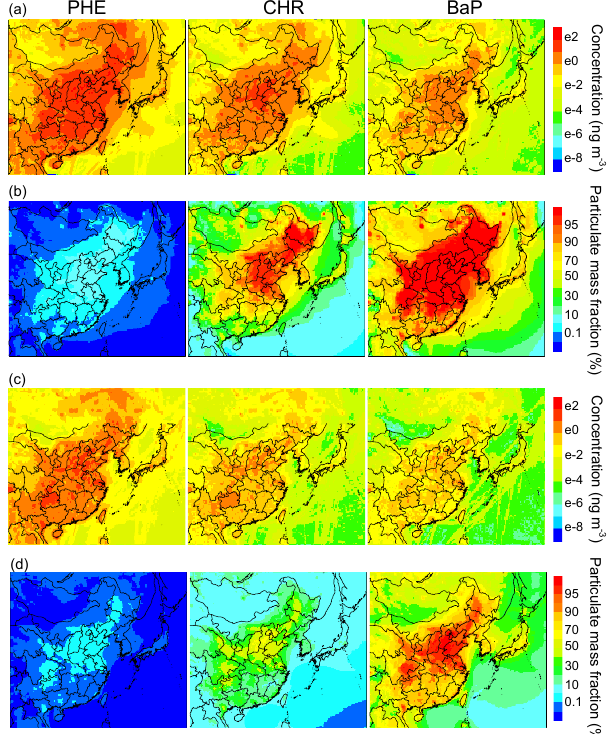
Figure 7. Simulated (a) surface concentrations and (b) particulate mass fractions of PHE, CHR and BaP averaged over 14–25 Febru- ary 2003. Simulated (c) surface concentrations and (d) particu- late mass fractions of PHE, CHR and BaP averaged over 11– 22 July 2013.